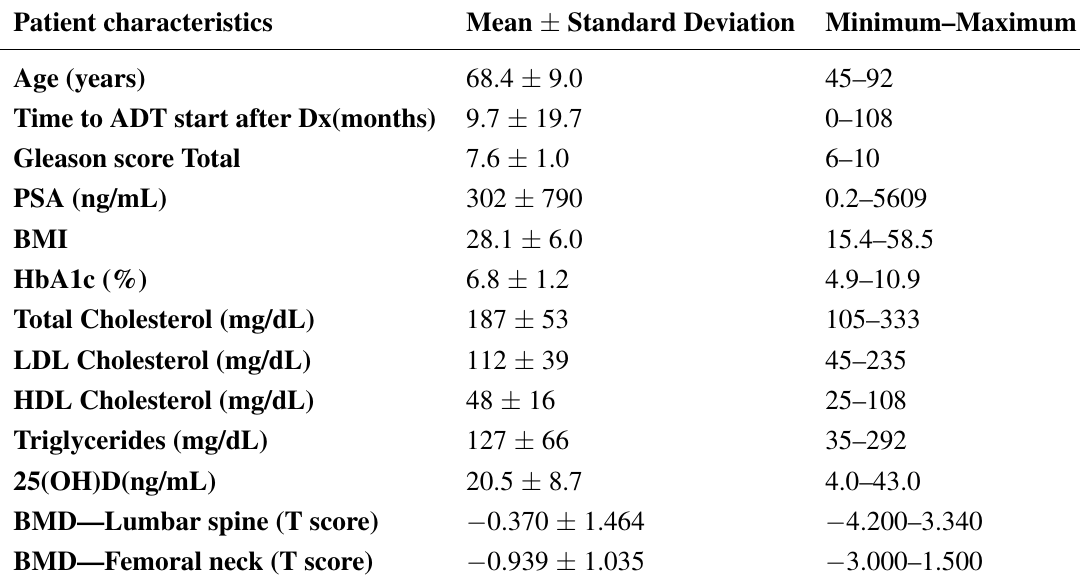
Figure 2. Patient Nationalities. The patients origin was from a total of 16 countries with 43.2% ( n = 48) being African Americans and 56.8% ( n = 63) immigrants, of which 52.4% ( n = 33) came from Haiti and other countries with lower proportions. Table 1. Baseline patient characteristics. Baseline clinical characteristics of patients in the study population ( n = 111). ADT = Androgen Deprivation Therapy. PSA = Prostate Specific Antigen. BMI = Body Mass Index. BMD = Bone Mass Density.